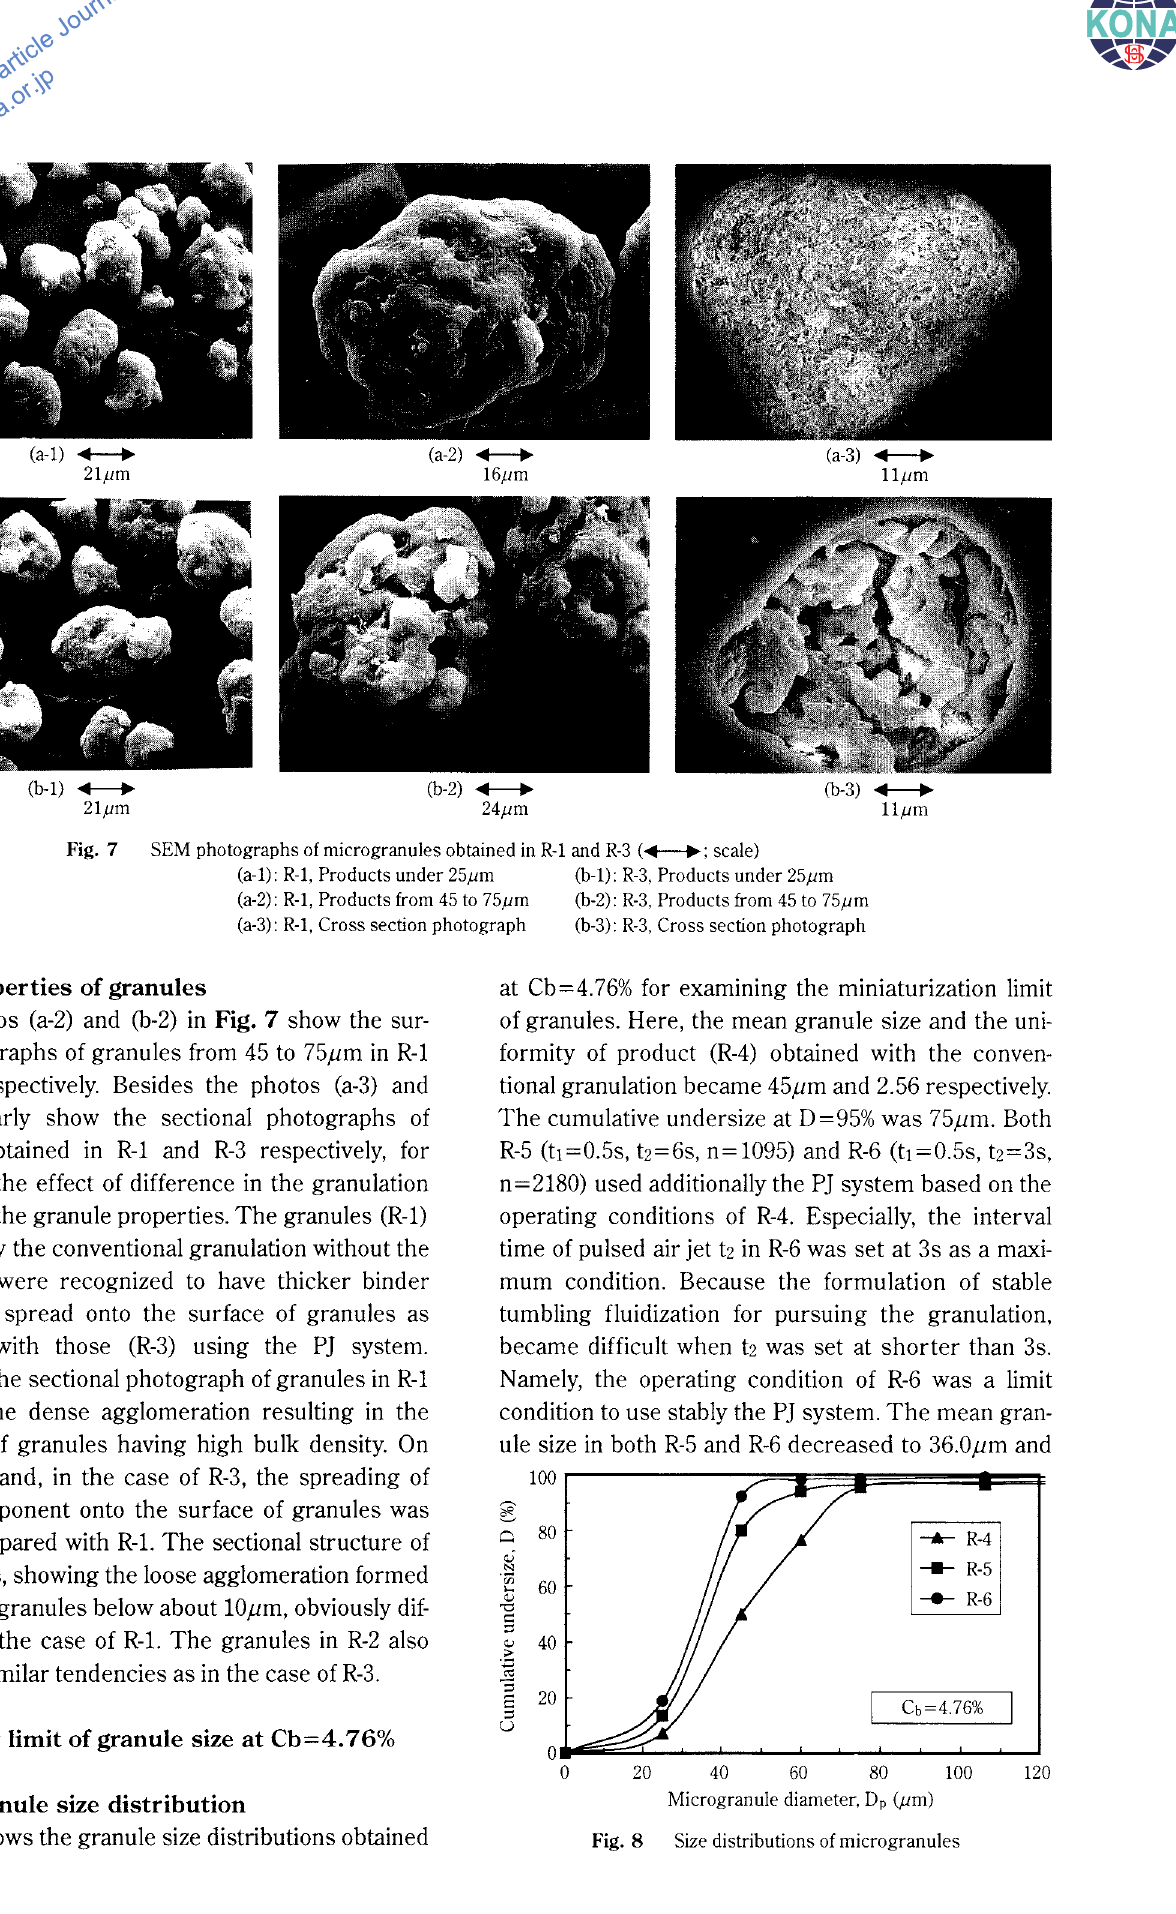
Size distributions of microgranules